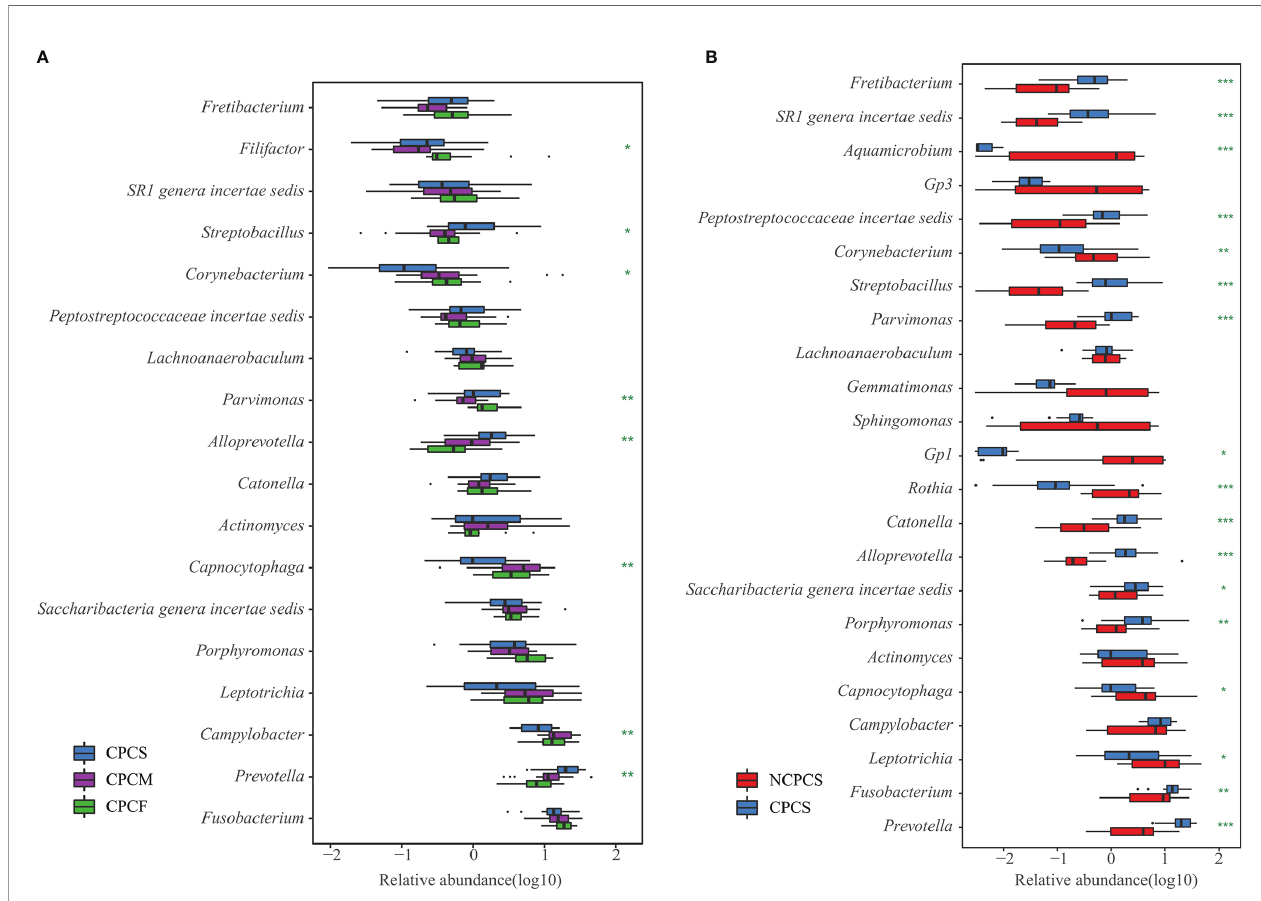
FIGURE 3 | Genus differential box plot of supragingival plaque microbiota. (A) Genera with dominant abundance in CPCS, CPCM, and CPCF were demonstrated. The blue, pruple, and green boxes represent group CPCS, CPCM, and CPCF, respectively. (B) Dominant genera were selected from NCPCS and CPCS. NCPCS and CPCS were respectively represented with red and blue boxes. *P < 0.05, **P < 0.01 and ***P < 0.001. NCPCS, non-CP children with severe or extremely severe caries; CPCS, CP children with severe or extremely severe caries; CPCM, CP children with mild-to-moderate caries; CPCF, CP children without